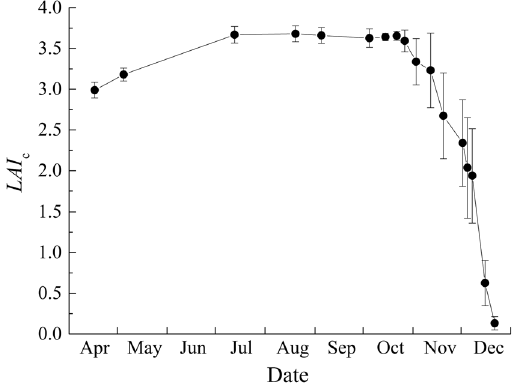
Figure 1. Seasonal variation of the canopy leaf area index ( LAI c ) of L . formosana (Data collected in 2014 and 2015 are combined. The error bar for each data point is the standard deviation from the measurements of six